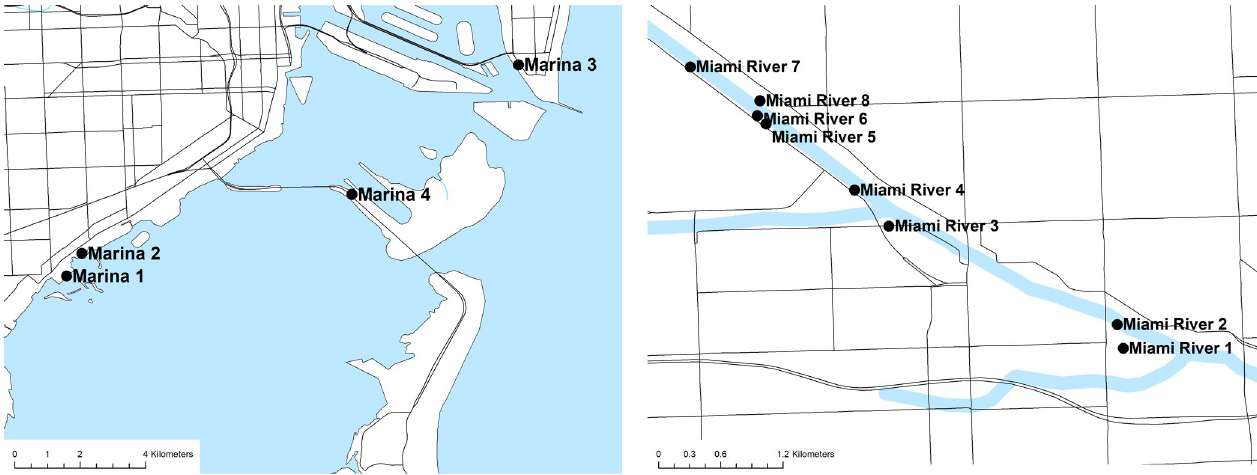
Fig 1. Map showing the location of the mosquito-surveyed maritime ports of entry in Miami-Dade, Florida. The figure was produced using ArcGIS 10.2 (Esri, Redlands, CA) using freely available layers from the Miami-Dade County’s Open Data Hub— https://gis-mdc.opendata.arcgis.com/.